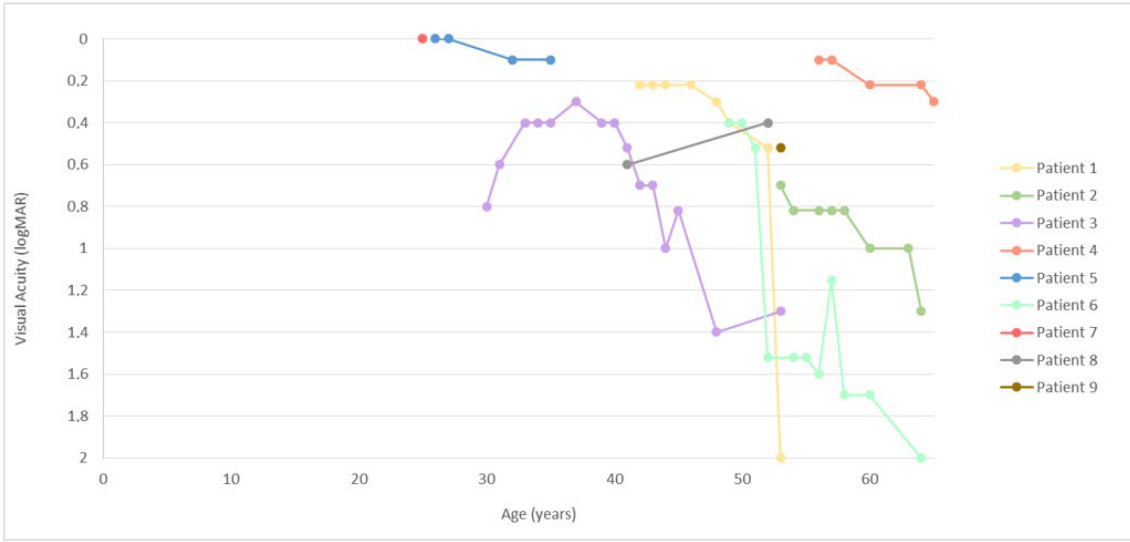
Figure 1. Best-corrected visual acuity of the right eye in relation to age. Note a relatively sharp decrease in visual acuity around the age of 50. Among patient with a non-null second allele, better acuity was observed in patient 4 (p.Arg303His), but not in patient 3 (p.Thr4315Pro). The increase in visual acuity of patient 8 was related to cataract surgery.